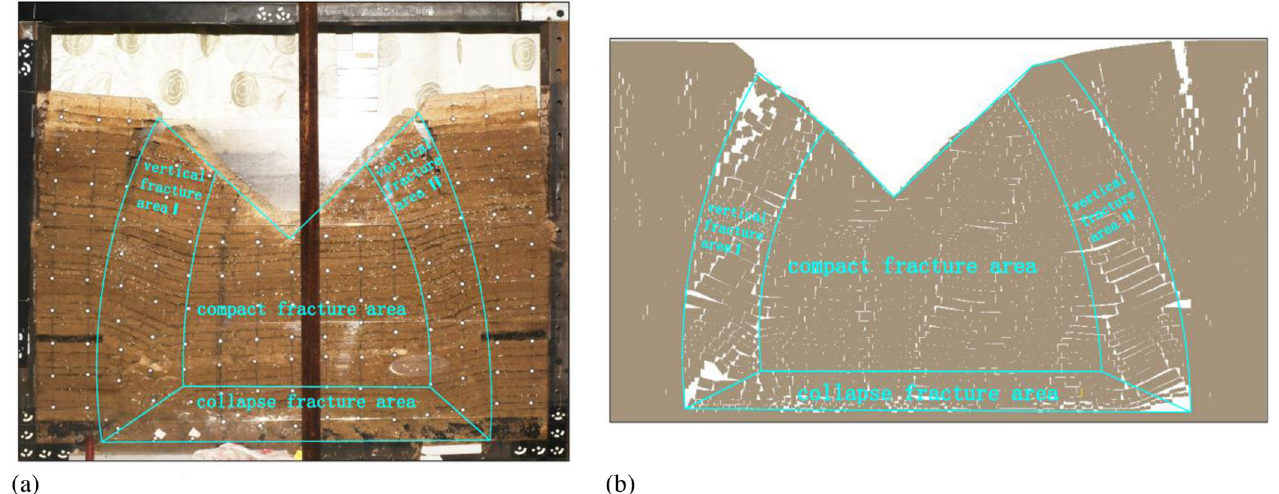
Fig 9. Division of overlying rock. (a) physical Similarity Simulation; (b) numerical Similarity Simulation.